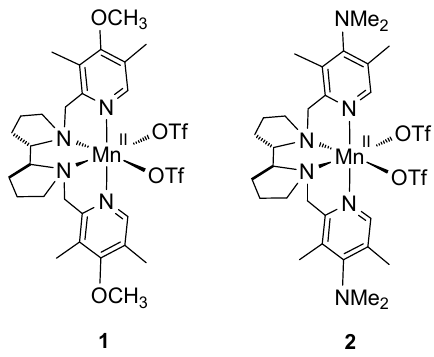
Figure 1. Manganese complexes used in this study. OTf = trifluoromethanesulfonate. The epoxidations with H 2 O 2 in the presence of bis -amino- bis -pyridine manganese complexes usually require adding carboxylic acid as a co-catalytic additive [28,29].